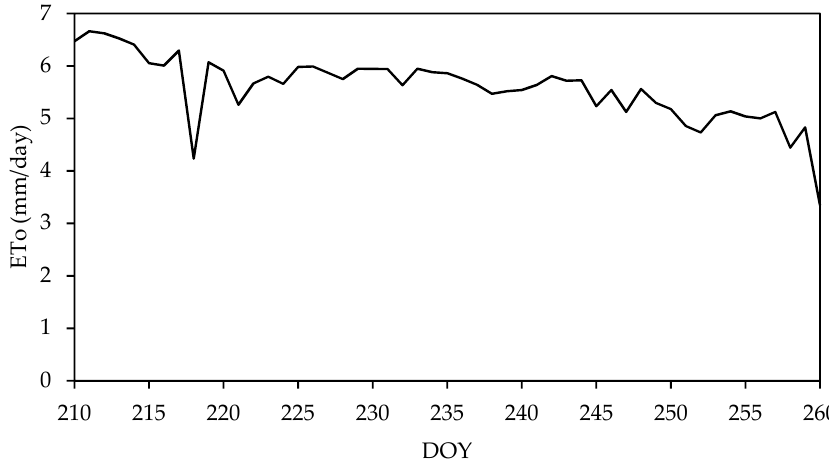
Figure 1. Reference evapotranspiration (ETo) during the experimental period. During DOY 210 to DOY 260, two irrigations of 33 mm each, and one rainfall of 36.3 mm, took place. Based on the irrigation and rainfall events, the period of 51 days was segmented into three distinct sub-periods (henceforth called drought cycles) that are indicated in Figure 2. Volumetric soil water content ranged between 18 and 29% during the experimental period. In particular, after each irrigation, soil moisture content reached the highest limit of 29%, and thereafter decreased progressively (Figure